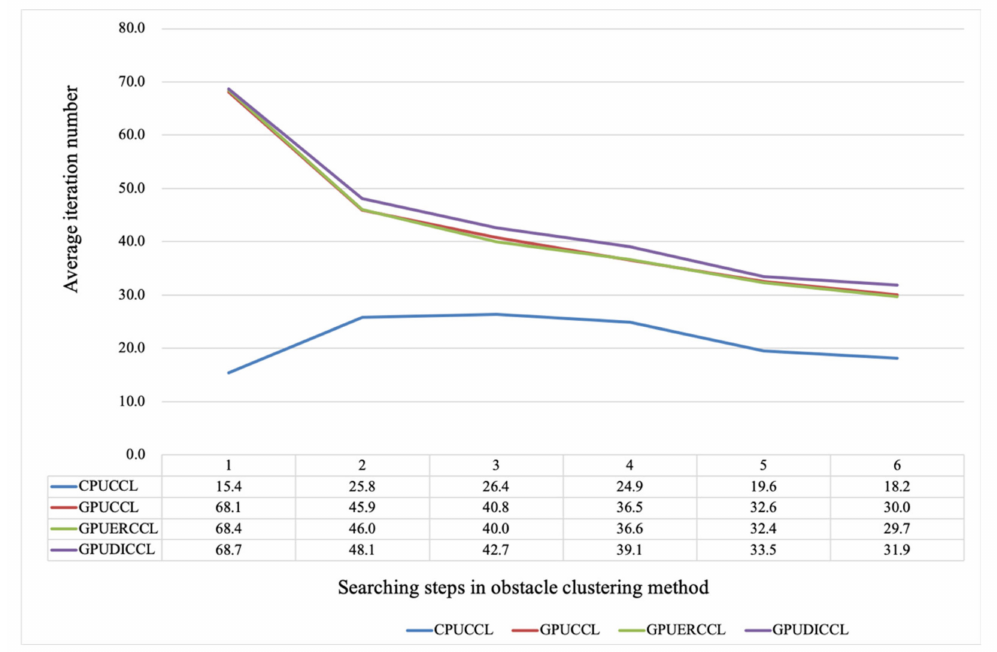
Figure 12. Iteration times under di ff erent searching ranges for di ff erent CLL implementation